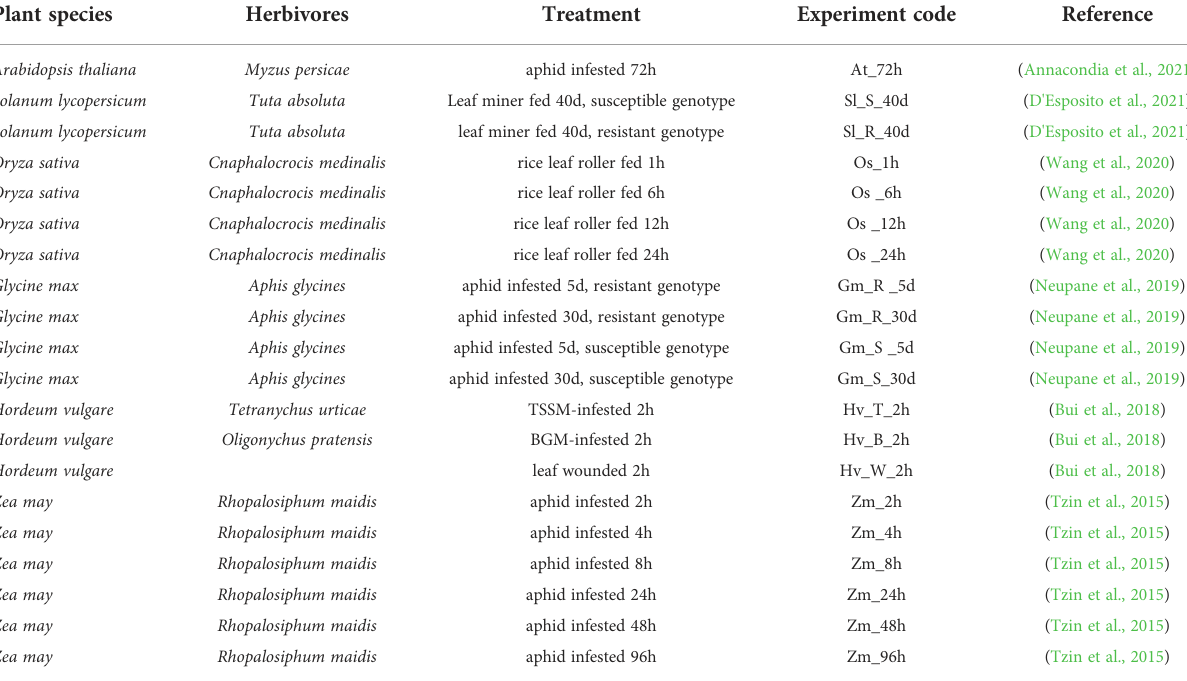
TABLE 1 Integrated RNAseq datasets of different plant species attacked by their corresponding main